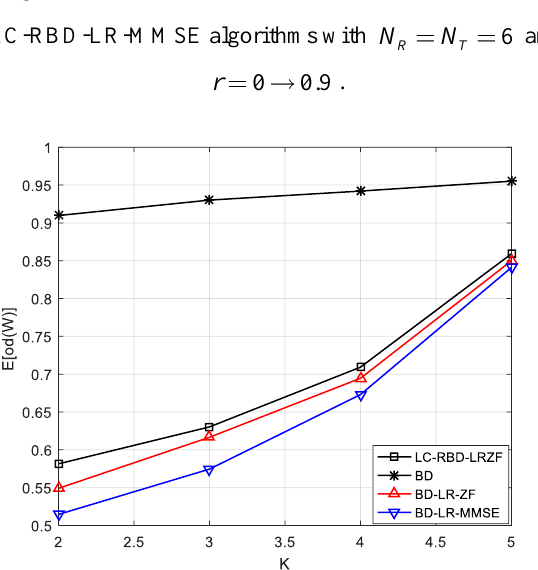
Fig. 3. ( [] ) E od W for BD-LR-ZF, BD, BD-LR-ZF and LC-RBD-LR-MMSE algorithms with r = 0.5, K = 2,3,4,5